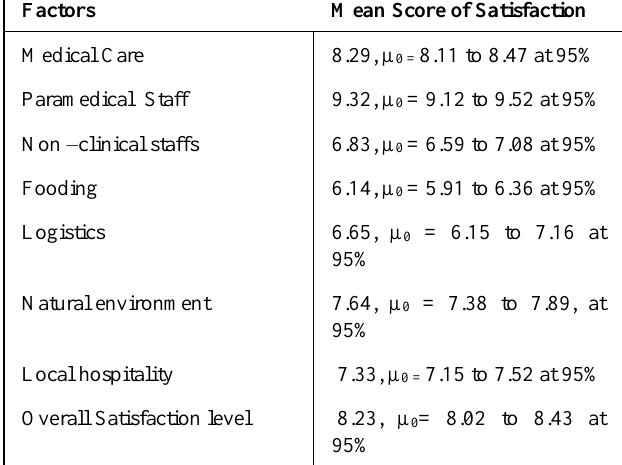
Table 5 (a) Level of satisfaction among international patient community (N=66)